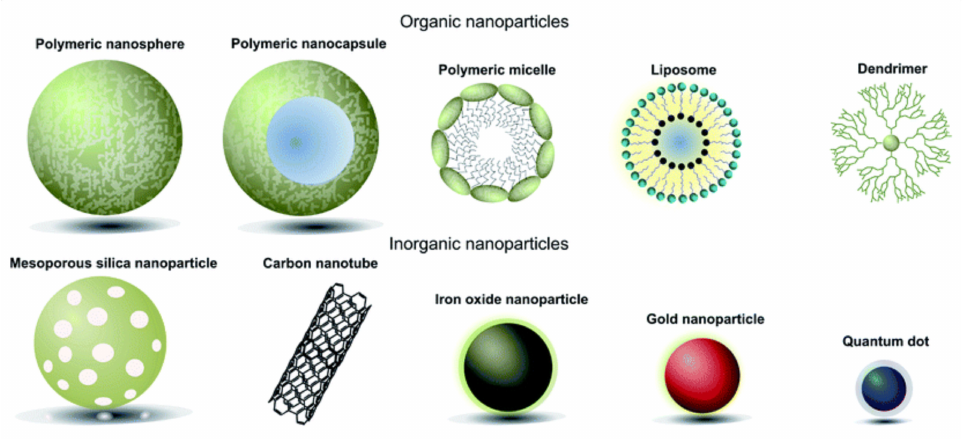
Figure 2. Classes of RNAi nanodelivery vehicles (subdivided into organic and inorganic nanoparticles). Reproduced with permission from Richards, D.A. et al., Chem Sci; published by Royal Society of Chemistry, 2016